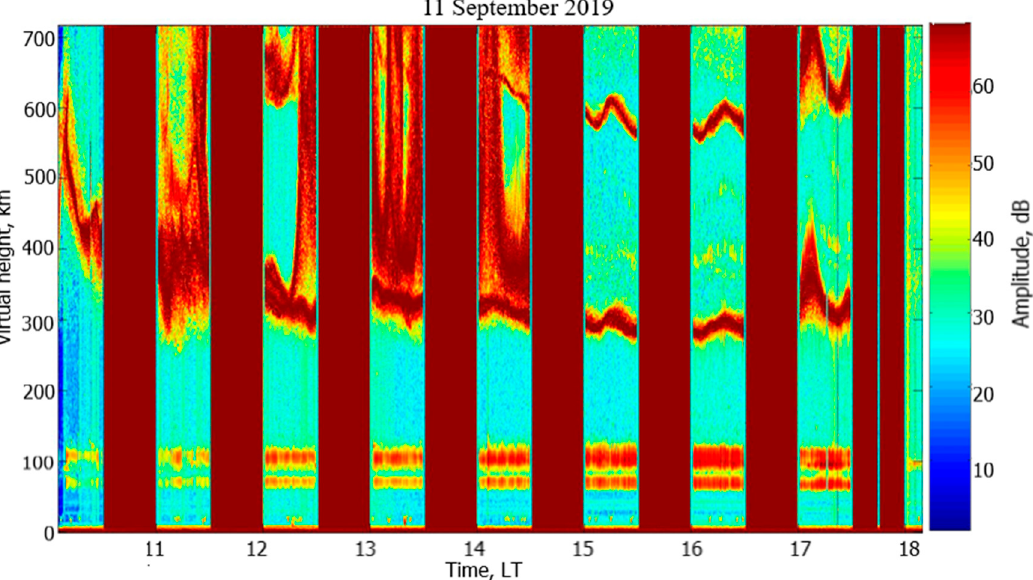
Figure 3. The virtual height-time dependence of the scattered-signal amplitude in 11 September 2019.